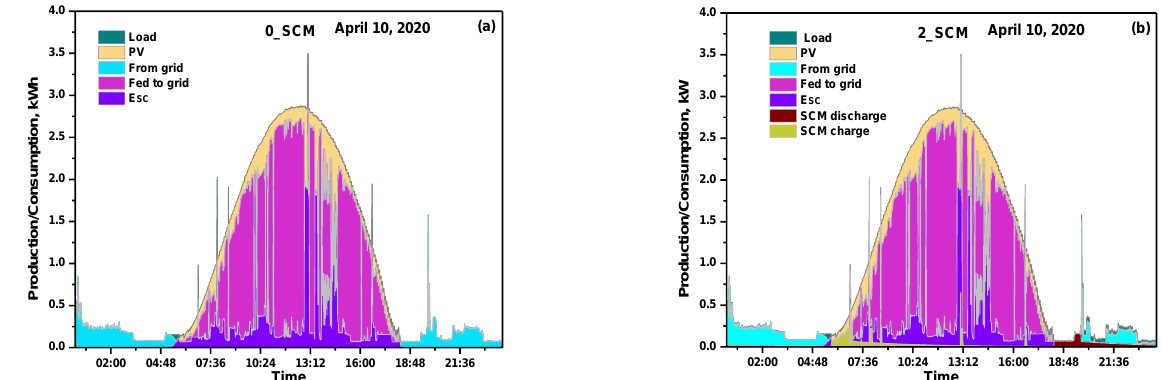
Figure 8. Power distribution for sunny day 10 April 2020 for 0 SCM units ( a ) and 2 SCM units ( b ), respectively.